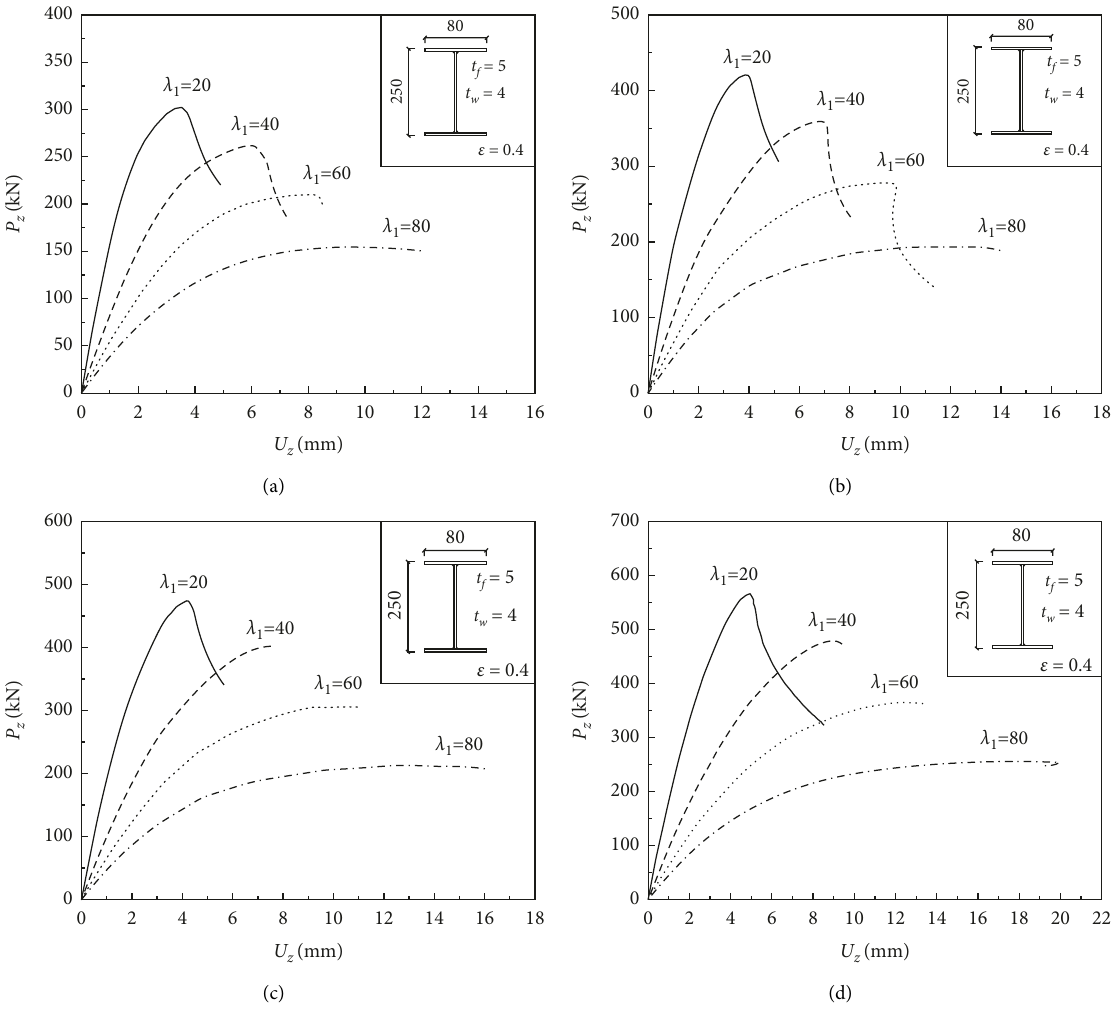
Figure 5: Axial compressive force P z versus compressive deformation U z curves: (a) the load–displacement of Q460; (b) the load–displacement of Q690; (c) the load–displacement of Q800; and (d) the load–displacement of